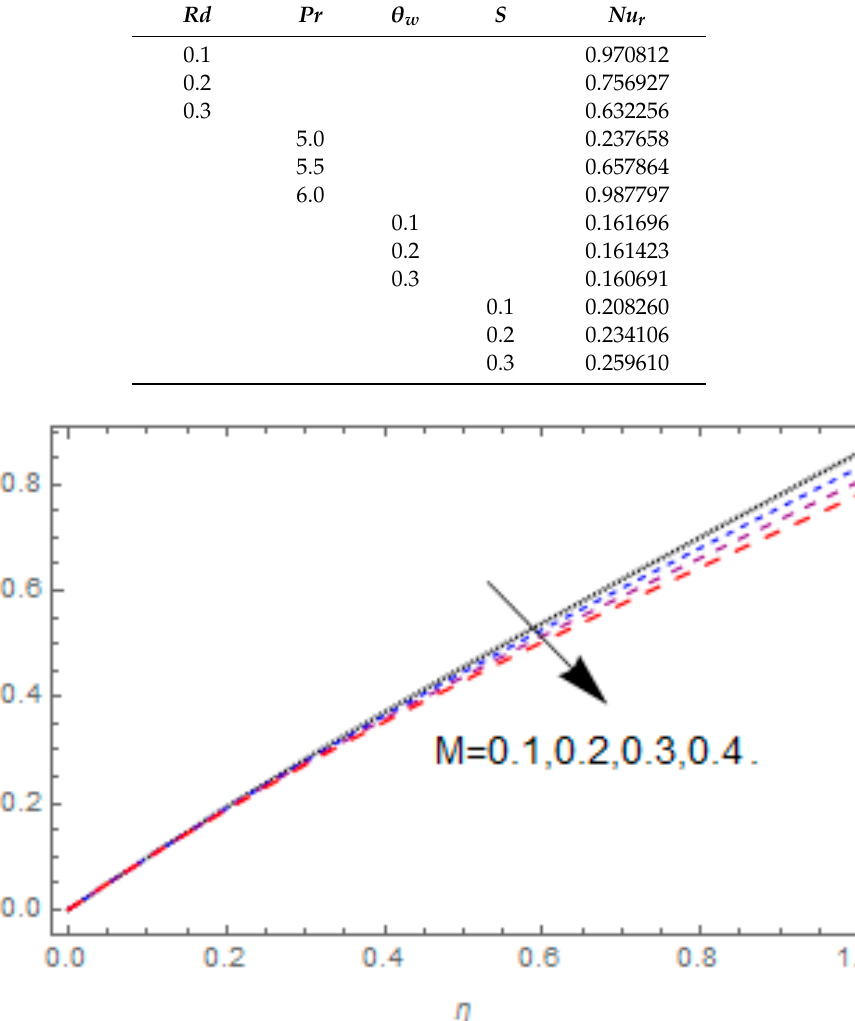
Table 7. The numerical values for heat transfer rate w.r.t. di ff erent parameters.